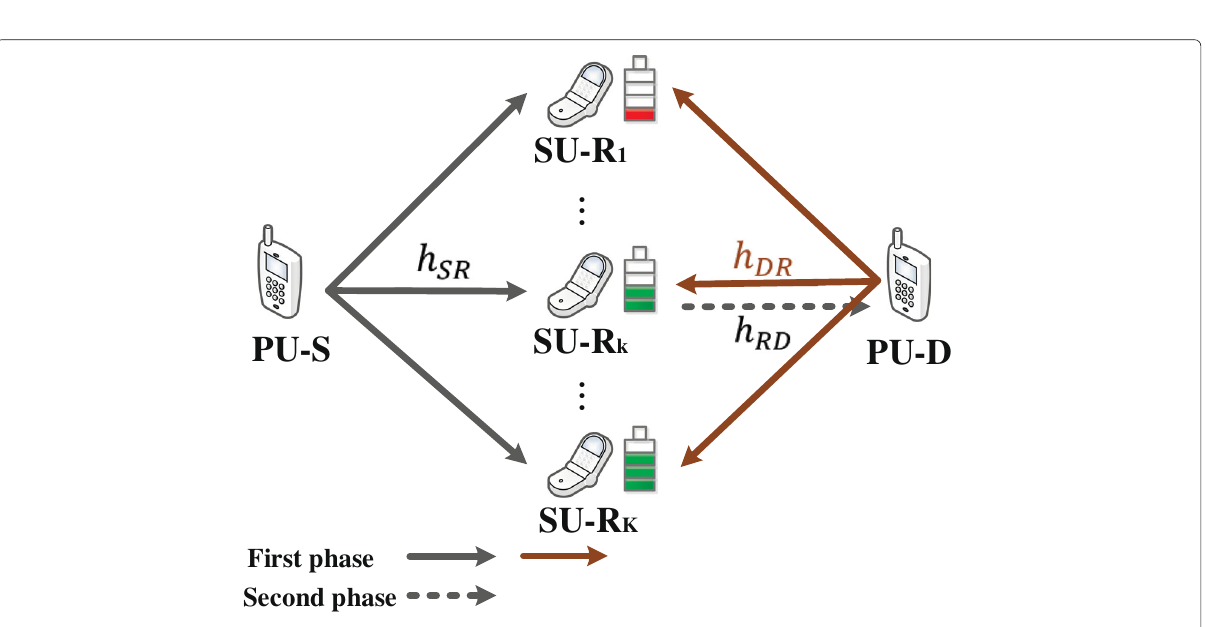
Fig. 3 Signal transmission model with untrusted